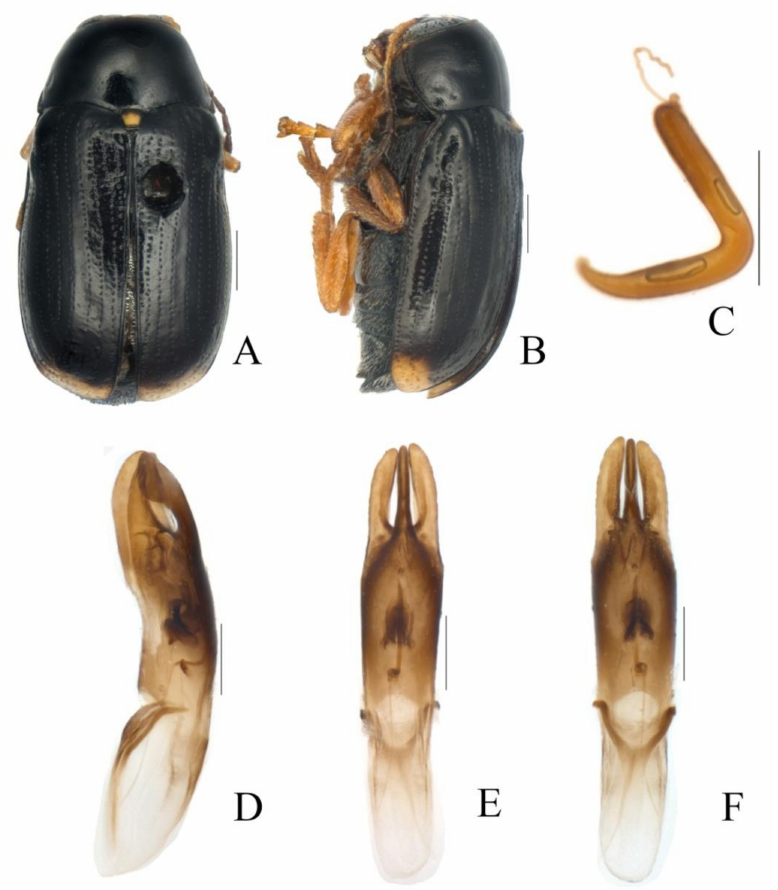
Figure 6. Cryptocephalus ( Burlinius ) tomurensis Duan & Zhou, sp. nov.: ( A ) habitus; ( B ) lateral view of habitus; ( C ) spermatheca; ( D ) lateral view of aedeagus; ( E ) dorsal view of aedeagus; ( F ) ven- tral view of aedeagus. (Scale bars: ( A , B ) = 0.5 mm, ( C – F ) = 0.2 mm) (( A , B , D – F ): holotype, male; ( C ): paratype,